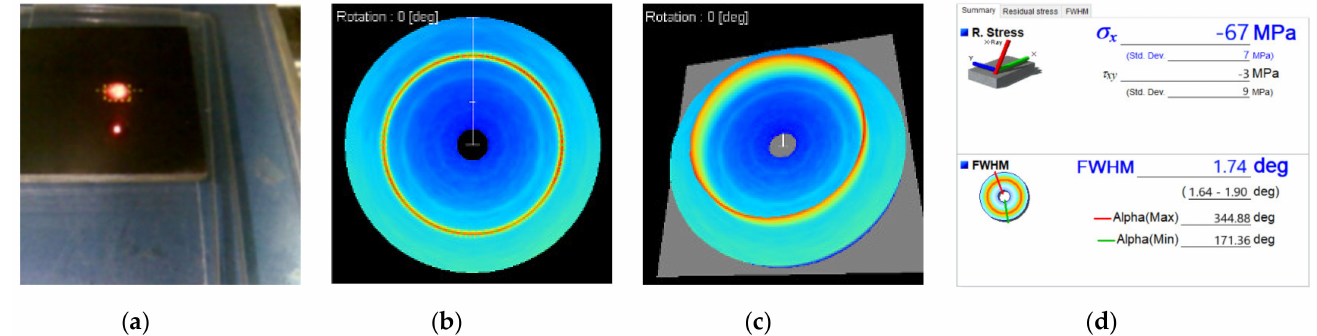
Figure 12. Surface residual stress test diagram and test results of Ti-6Al-4V after polishing. ( a ) Test diagram; ( b ) Debye ring(2D); ( c ) Debye ring(3D); ( d ) surface residual